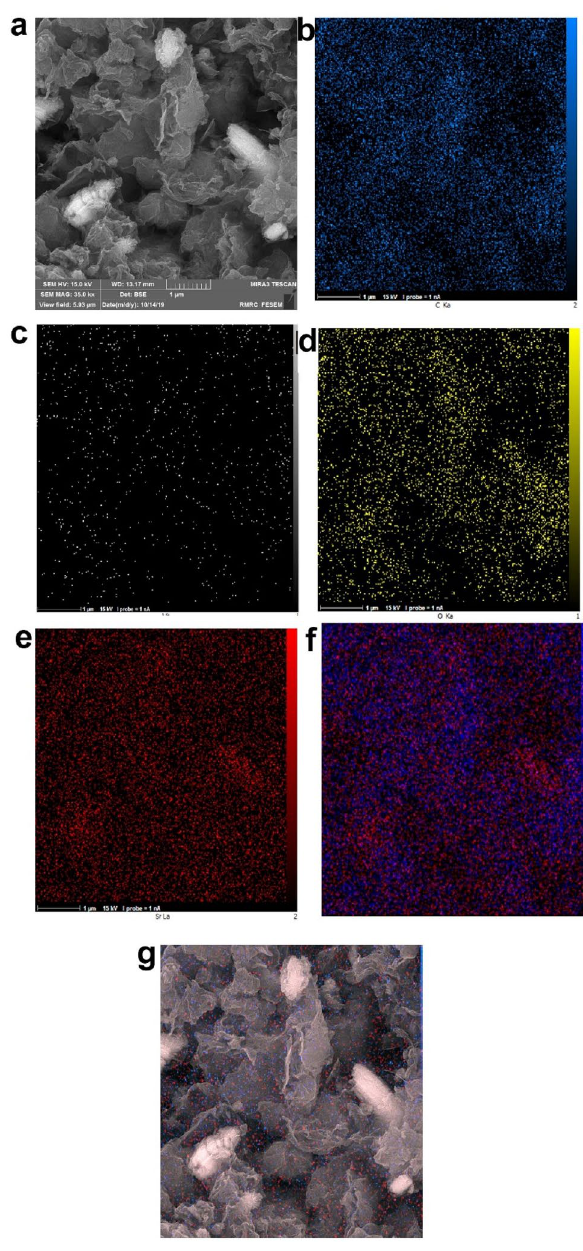
Figure 6. ( a–e ) Elemental mapping images of C, N, O and Sr elements of Sr-BSA-rGO. ( f ) Merged image of carbon and strontium. ( g ) Merged image of carbon and strontium in